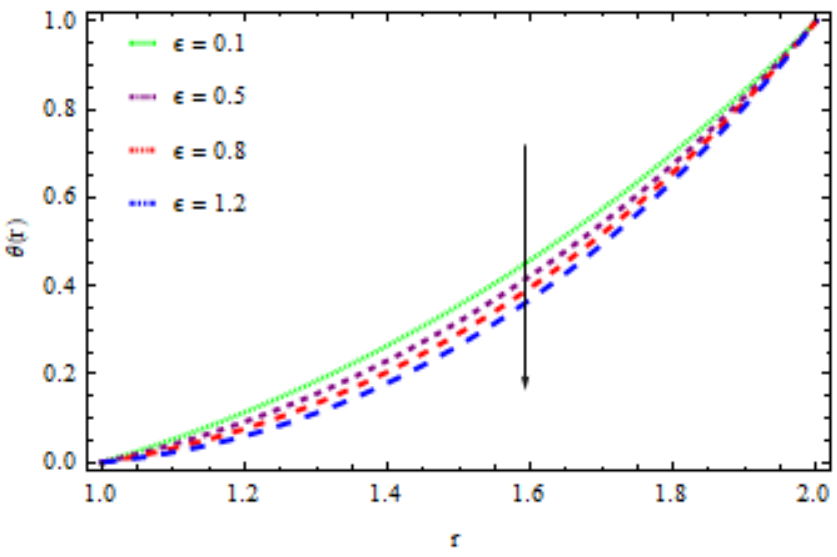
Figure 8. The influence of ε on temperature when Q = 0.6, B r = 1.4, M = 0.6, N = 0.01, K p = 0.6.